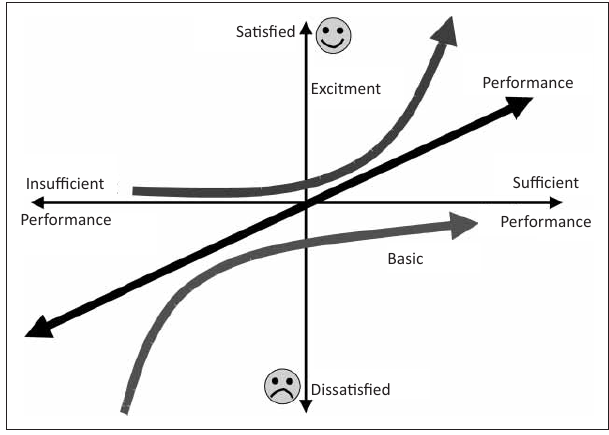
FIGURE 1: Customer satisfaction